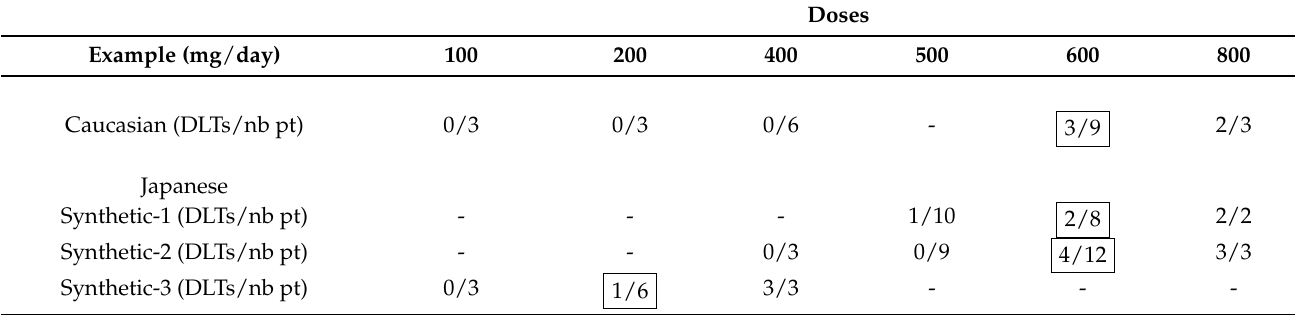
Table 1. Number of dose-limiting toxicity and total number of patients accrued at each dose for 1 Caucasian trial and 3 Japanese synthetic trials. In the first column, the trial population is specified. A dash (-) means that the dose was not tested in the specified population. A box denotes the dose that has been defined as maximum tolerated dose (MTD). Doses